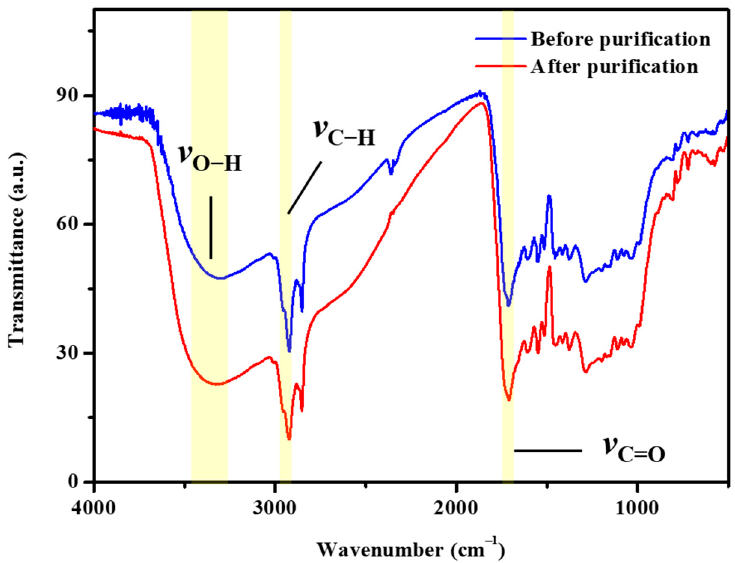
Figure 1. Infrared spectrum of total triterpenoids from the sclerotia of PTRSS.